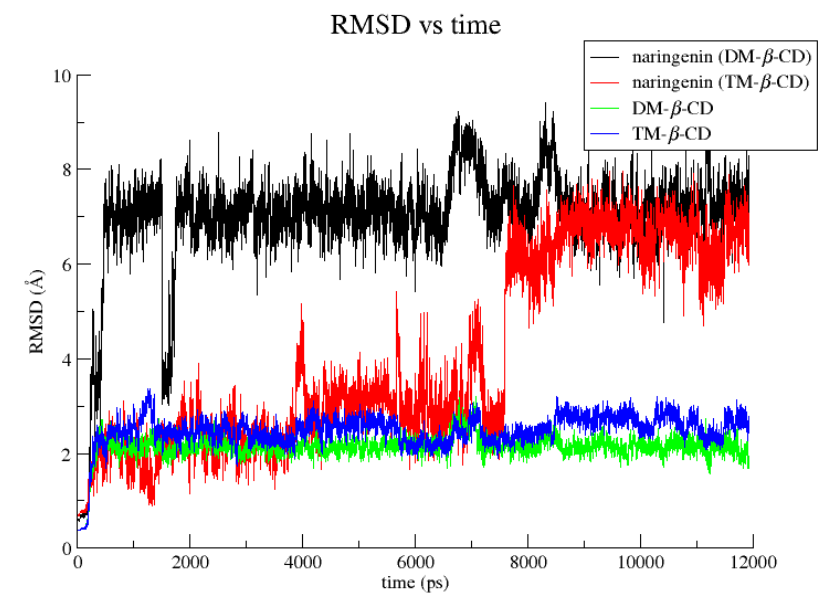
Figure 4. Root-mean-square deviation (RMSD) vs. time of guest and host molecules of naringenin / DM- β -CD and naringenin / TM- β -CD inclusion complexes